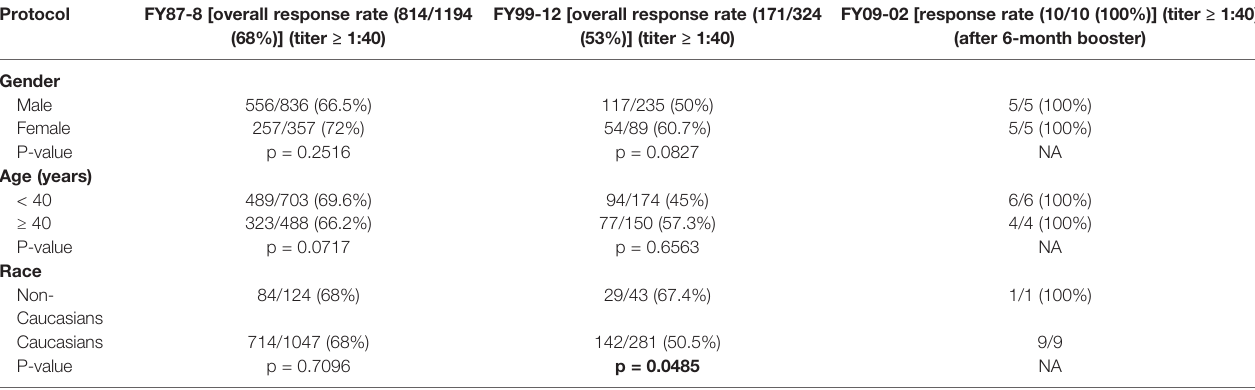
TABLE 3 | Overall response rates to WEEV booster doses by subject demographics (1987 – 2011).